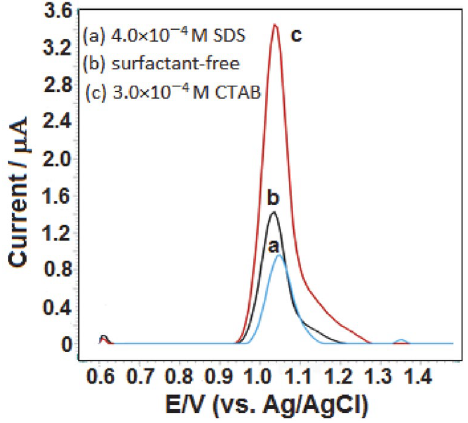
Figure 6. The stripping voltammograms of 2.4 × 10 –7 M pantopra- zole in BR buffer, pH 7.0 in the absence and presence of surfactants. Electrode, PGE. AdSV conditions: accumulation time 30 s at open-circuit condition. SWV parameters: frequency, 50 Hz; step potential, 8 mV; pulse amplitude, 50 mV.